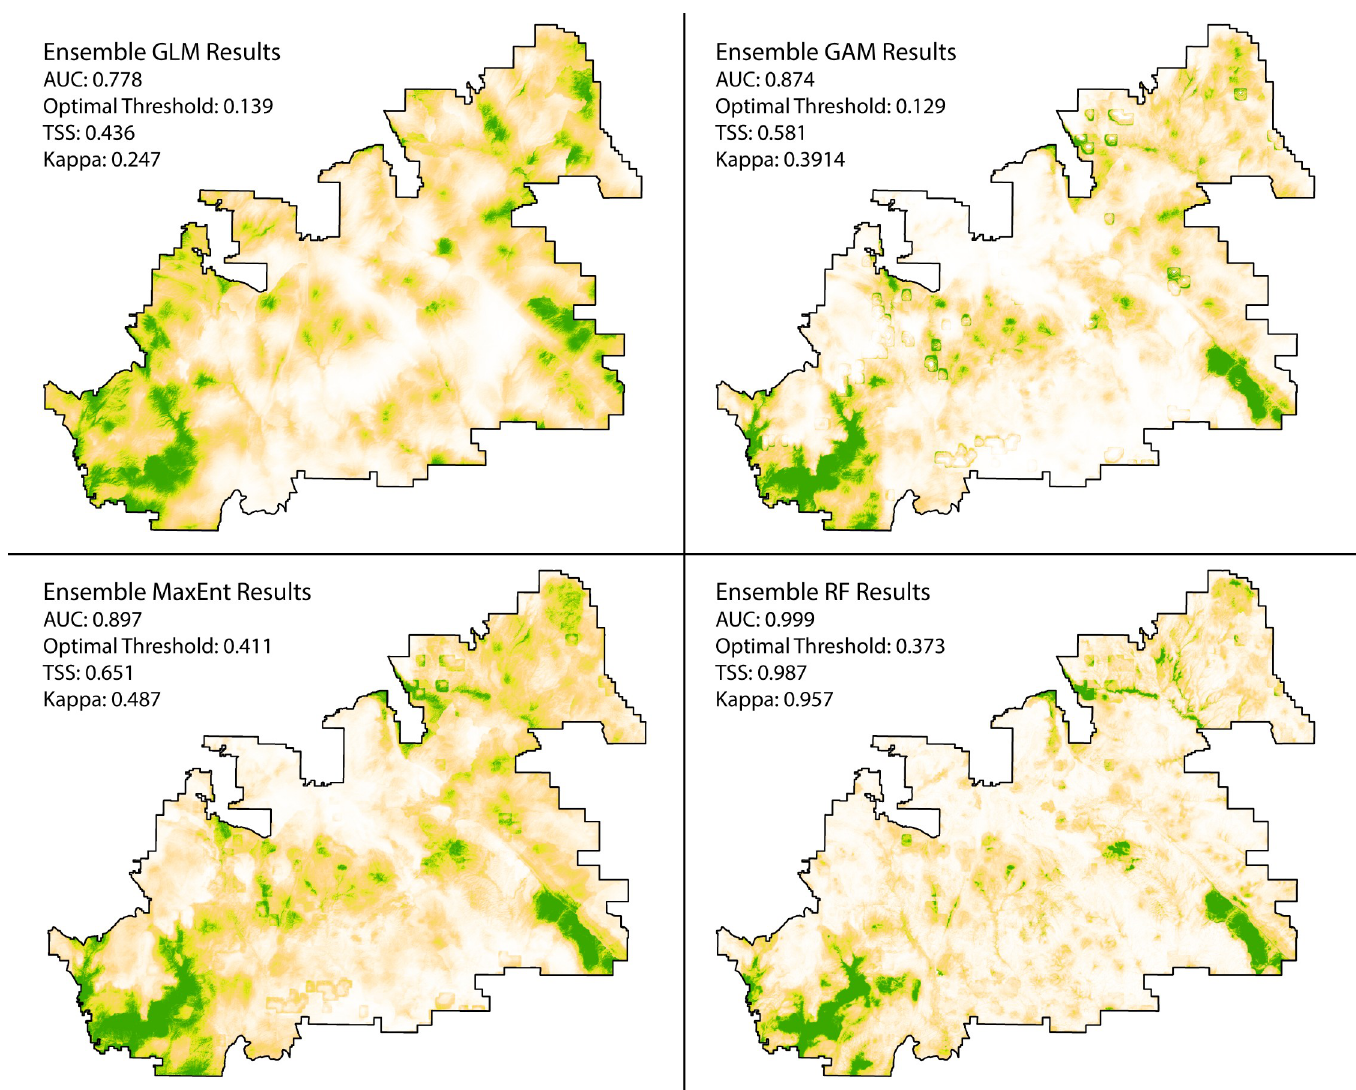
Fig 5. Ensemble maps using the predictions from each approach’s four-fold cross-validation. AUC and optimal threshold are determined using all presence and absence points, making the AUC a measure of goodness-of-fit. The optimal threshold is then used to determine the True-skill Statistic (TSS) and Kappa. AUC is a threshold-independent measure, while TSS and Kappa are threshold-dependent